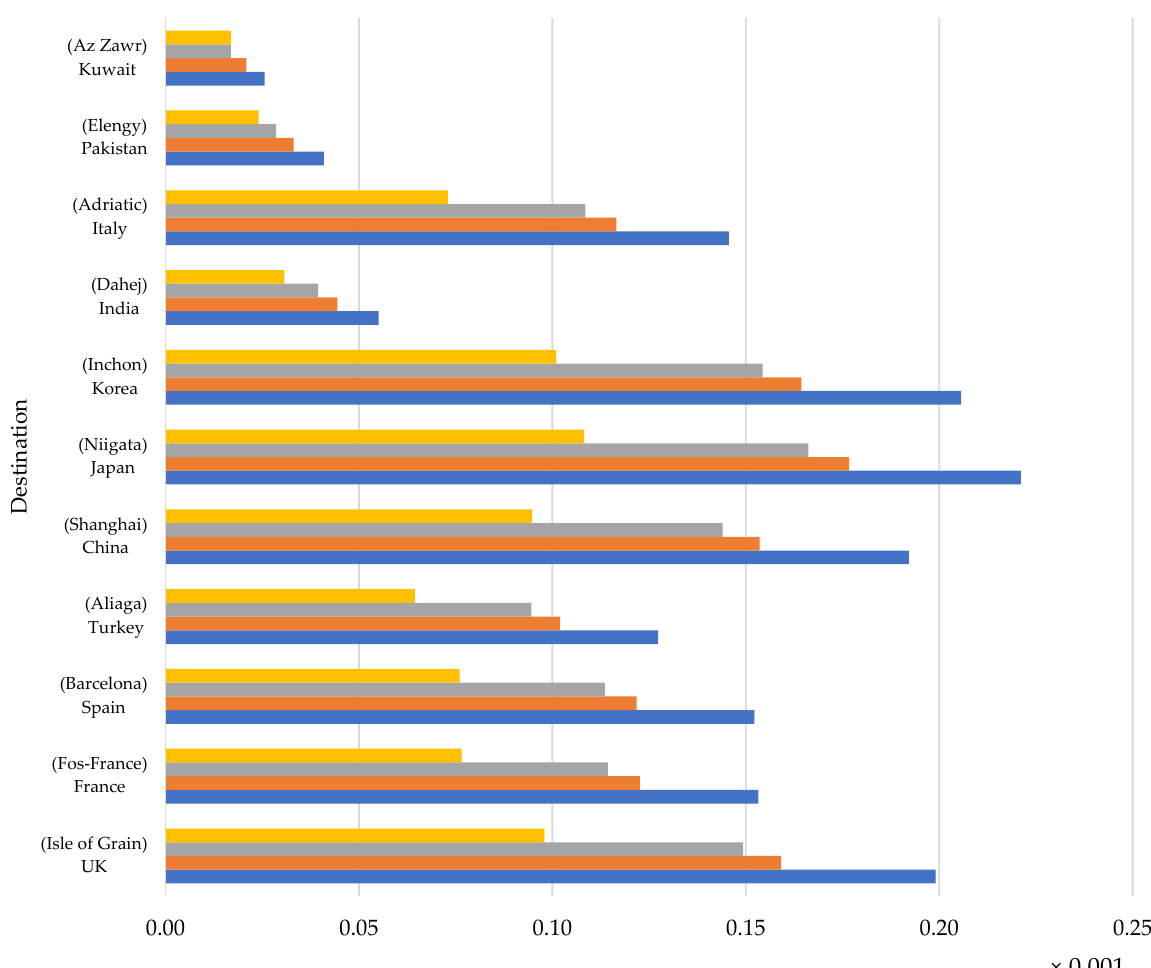
Figure 7. Overall social human health impact factors while accounting for annual emissions.